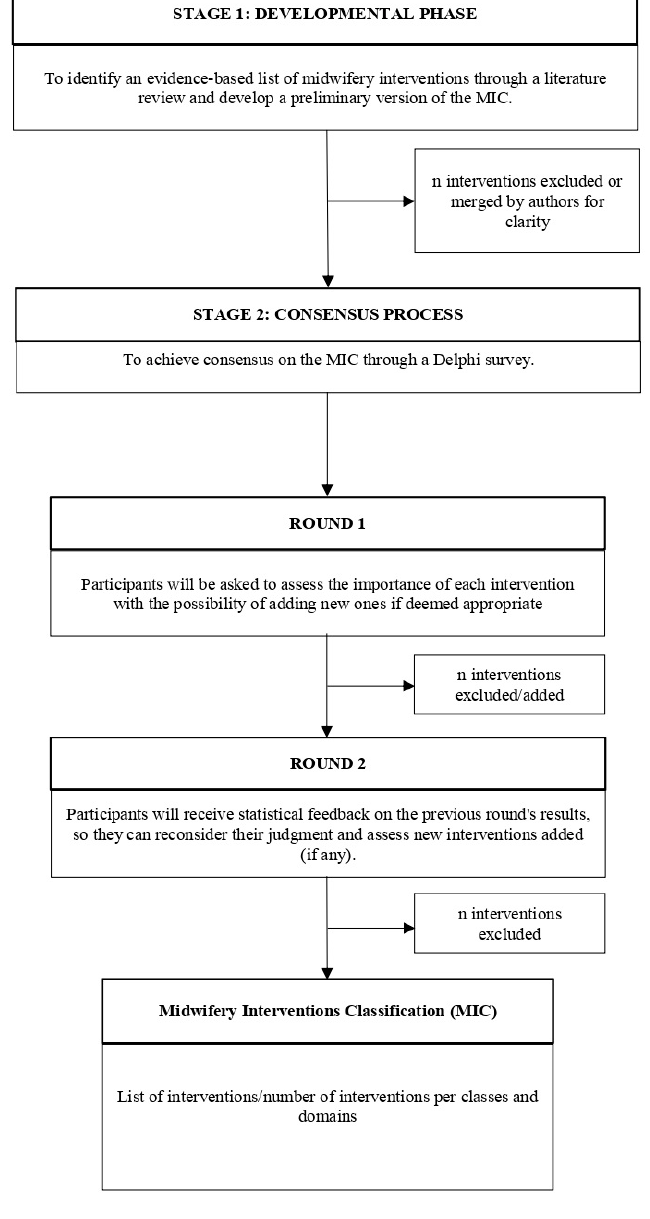
Figure 1. Flowchart of the study design. Group